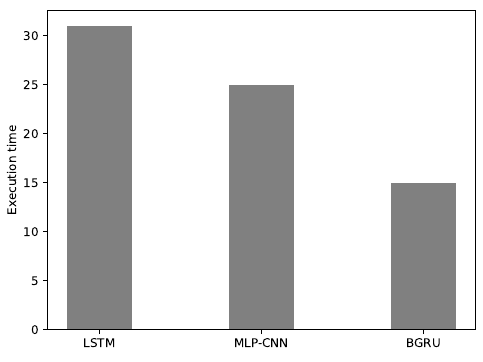
Figure 23. Execution time of BGRU and other deep learning